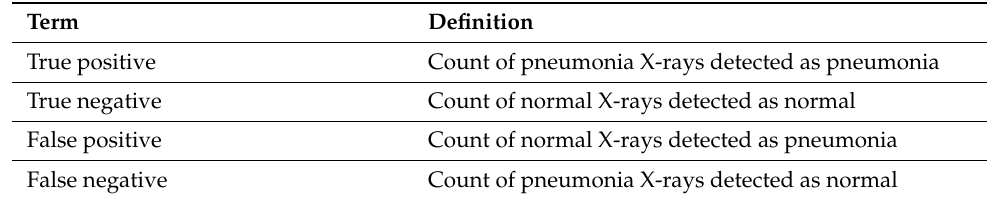
Table 6. Definitions of TP, TN, FP and